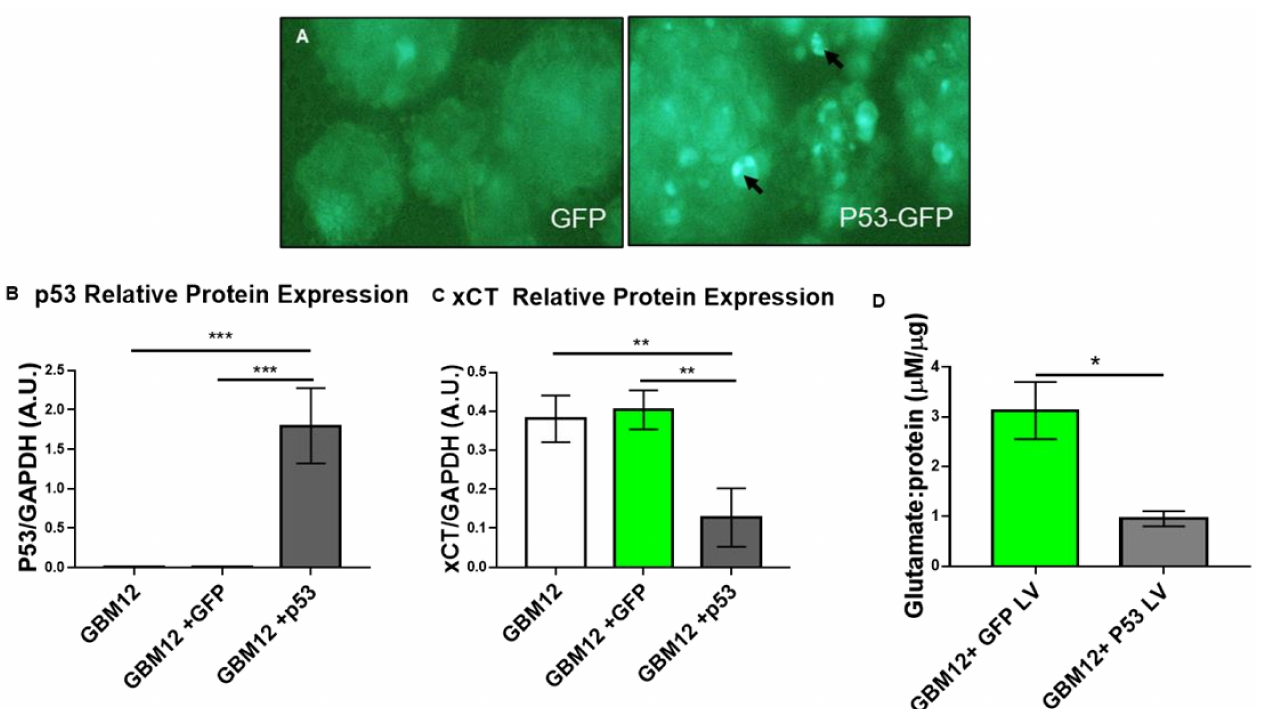
Figure 4. p53 over-expression decreases in vitro GBM xCT expression and glutamate release. ( A ) Fluorescent images were acquired with a Nikon Ti2 microscope to document the successful infection of GBM12 cells with either a lentivirus over-expressing GFP (left) or p53 conjugated to GFP (right); 10x magnification. Densely expressed GFP in the P53-GFP over-expressing tumor cells (arrows). ( B , C ) Western blot analysis of transduced tumor cells shows P53 overexpression in GBM12 cells ( B ) reduces high xCT expression ( C ) compared to non-transduced and GFP controls. All experiments represent at least three biological replicates. An ordinary one-way ANOVA with Tukey’s multiple comparisons test was performed. Error bars represent the mean ± S.E.M. *** p < 0.005, ** p < 0.01 ( D ) Media were taken from transduced cells analyzed in ( B , C ) and the glutamate content was measured. p53 over-expression reduced glutamate release in GBM12 cells. An unpaired, two-tailed t -test was performed. Error bars represent the mean ± S.E.M. Experiments represent at least three biological replicates. * p <